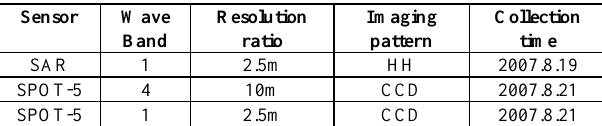
Table 1 The Main Parameters Of Data